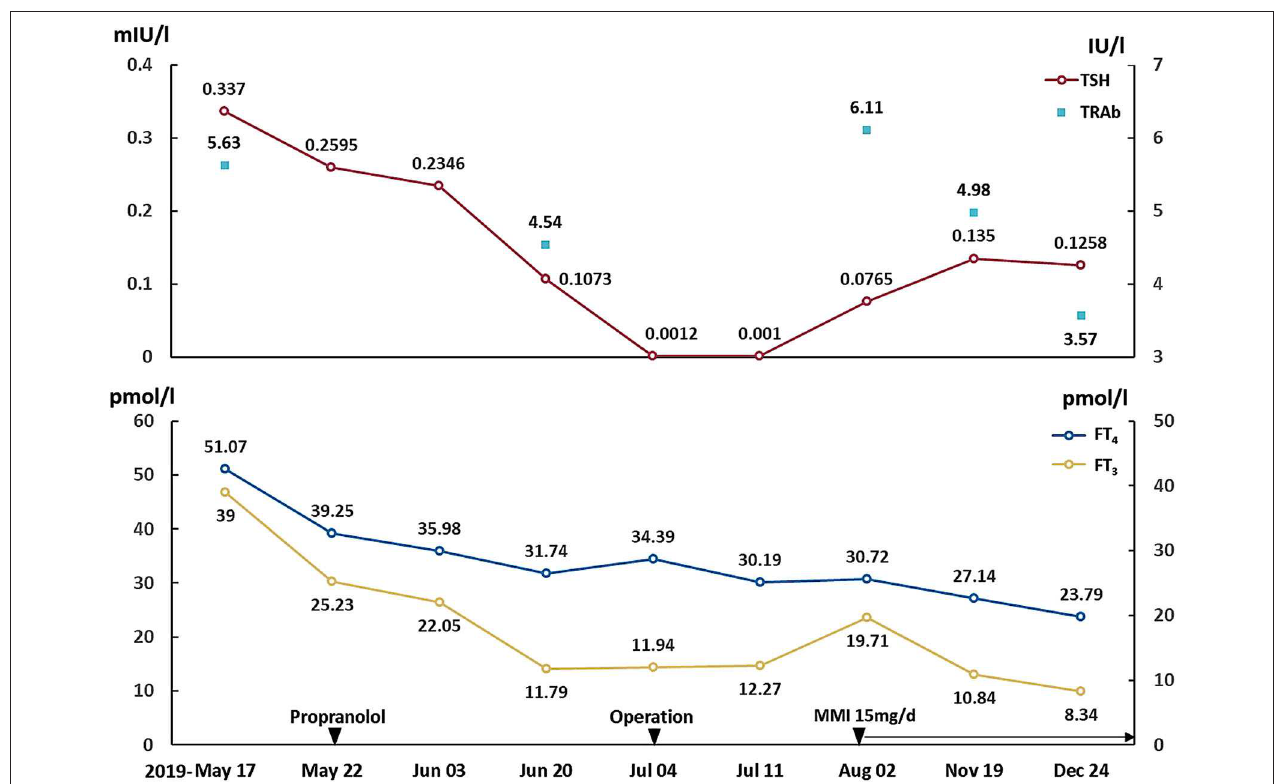
FIGURE 2 | Changes of TSH, FT 3 , FT 4 , and TRAb. Propranolol was prescribed on May 22, 2019. The operation was performed on July 4, 2019, and the methimazole was started on August 2, 2019. TSH, thyroid-stimulating hormone; FT 3 , free triiodothyronine; FT 4 , free thyroxine; TRAb, TSH receptor